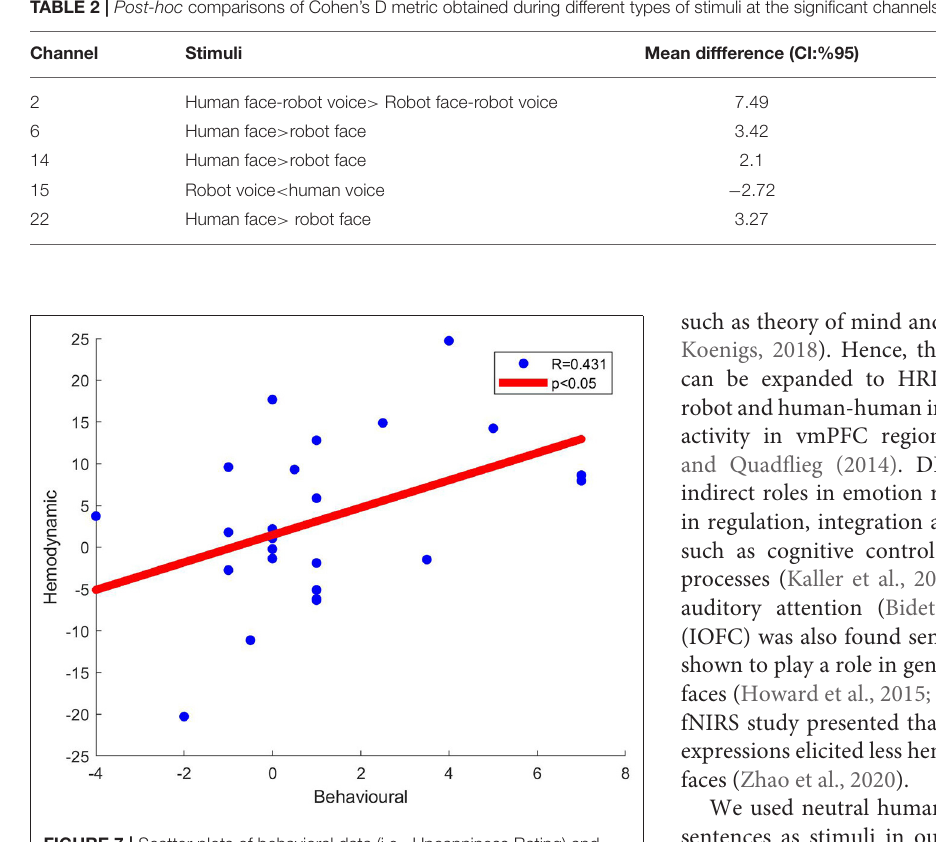
FIGURE 7 | Scatter plots of behavioral data (i.e., Uncanniness Rating) and Cohen’s D metrics computed for Human Face - Robot Voice > Robot Face - Robot Voice contrast. Each dot represents a comparison of changes in behavioral score and hemodynamic parameter of channel 22 for each subject. The two variables were found to be linearly correlated ( p <